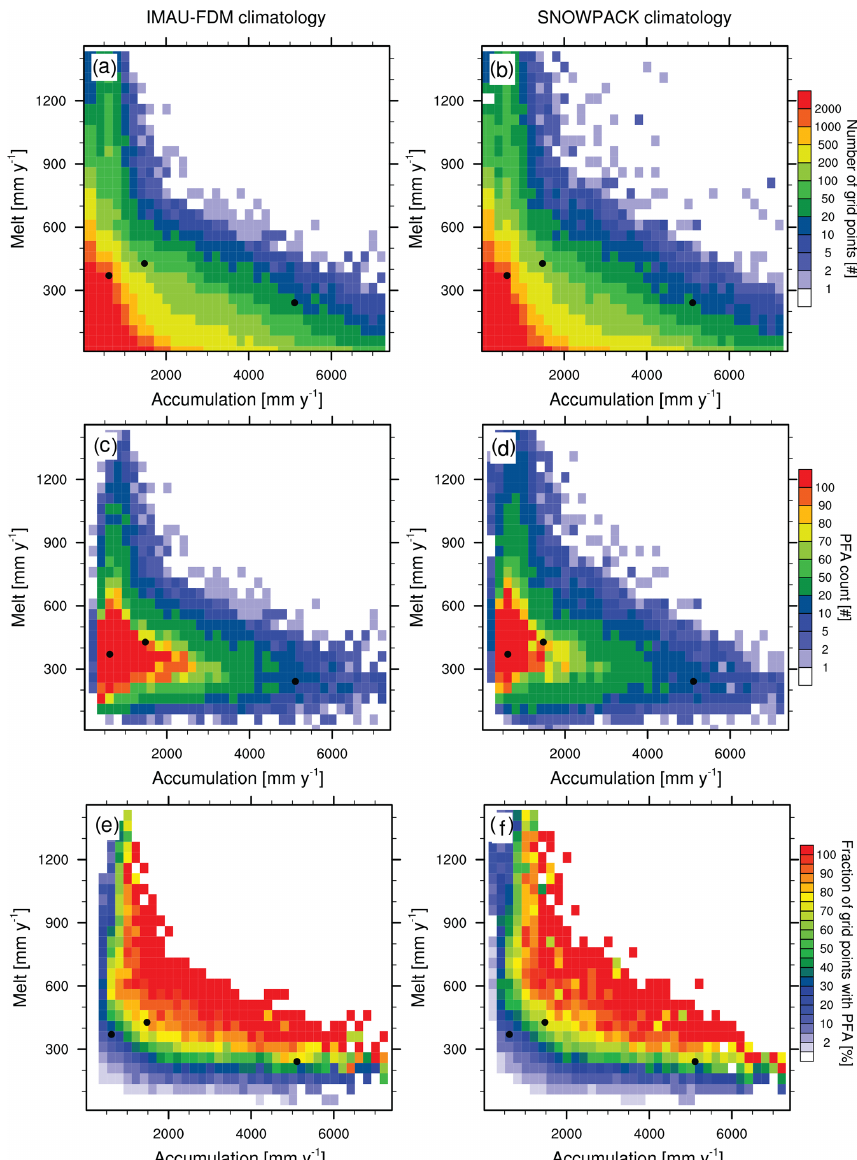
Figure 8. (a, b) Total number of model grid points in IMAU-FDM (left column) and SNOWPACK (right column), (c, d) total number of PFA occurrences for all model grid points in the respective hydrological year of the PFA, and (e, f) percentage of total number of PFA occurrences in (c, d) (with respect to Fig. 8a, b) as a function of yearly surface meltwater production ( y axis) and accumulation ( x axis). PFA numbers are binned in 50mmw . e . yr − 1 intervals in the y direction and by 200mmw . e . yr − 1 in the x direction. Grid points with only one occurrence are not